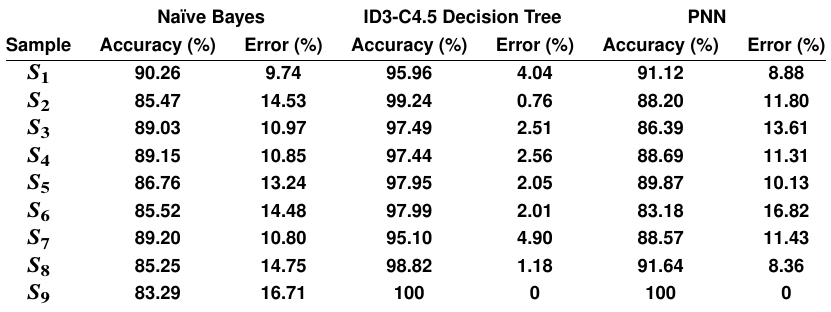
Table 5. Accuracies and errors using Naïve Bayes, a decision tree and a probabilistic neural network